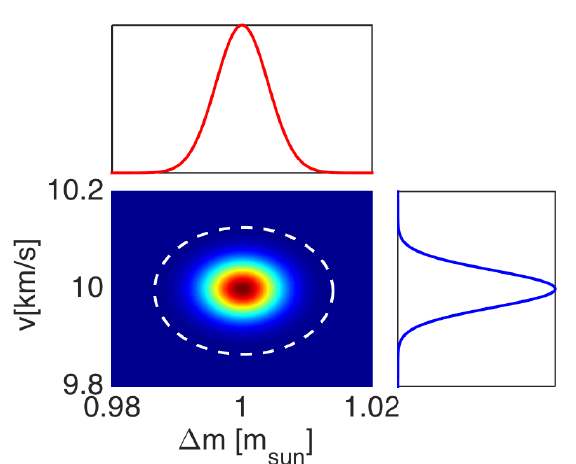
Figure 6. Likelihood of the recoil velocity v and mass loss ∆ m derived from the Fisher matrix. The white dashed ellipse shows the 3 σ confidence level. The upper and right-hand panels show the marginalized probability distribution for ∆ m and v ,